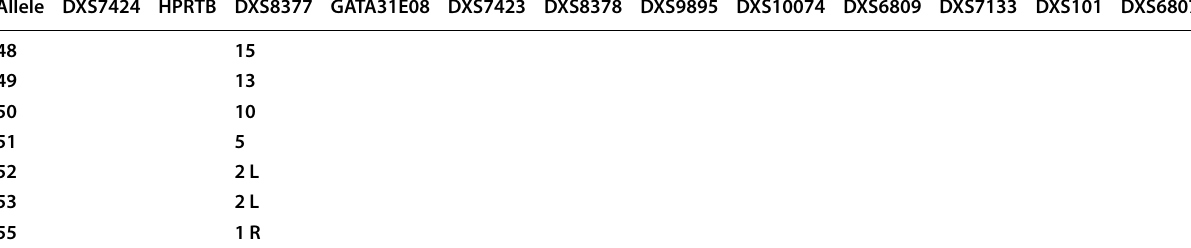
Table 5 Forensic efficiency parameter: power of discrimination (PD) of 12 XSTR loci for 200 Arab Iraqi populations